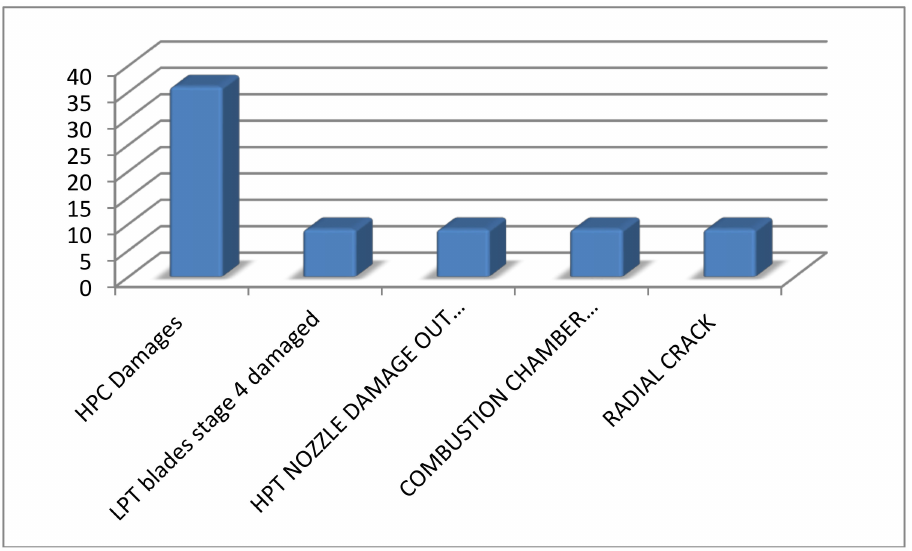
Figure 10. Number of removals—failure